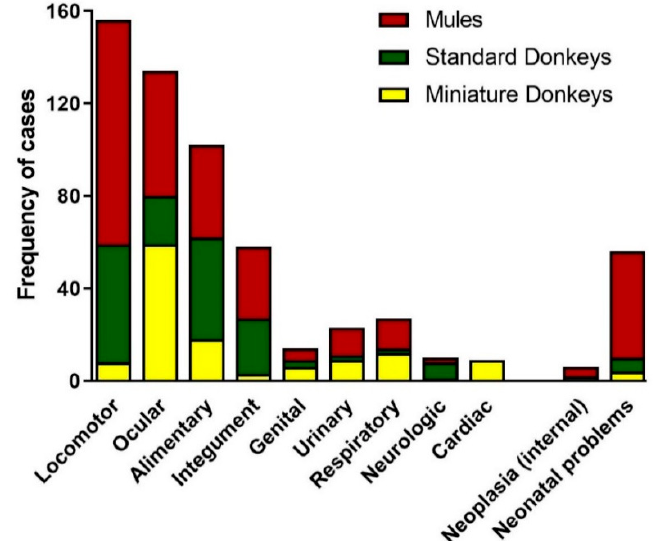
Figure 9. Distribution of Medical Complaint Visits of Donkeys and Mules from 2008 to 2017. The visits were categorized according to the primary body systems involved in the presenting medical complaint. Standard donkeys (green), miniature donkeys (yellow), and mules (red).